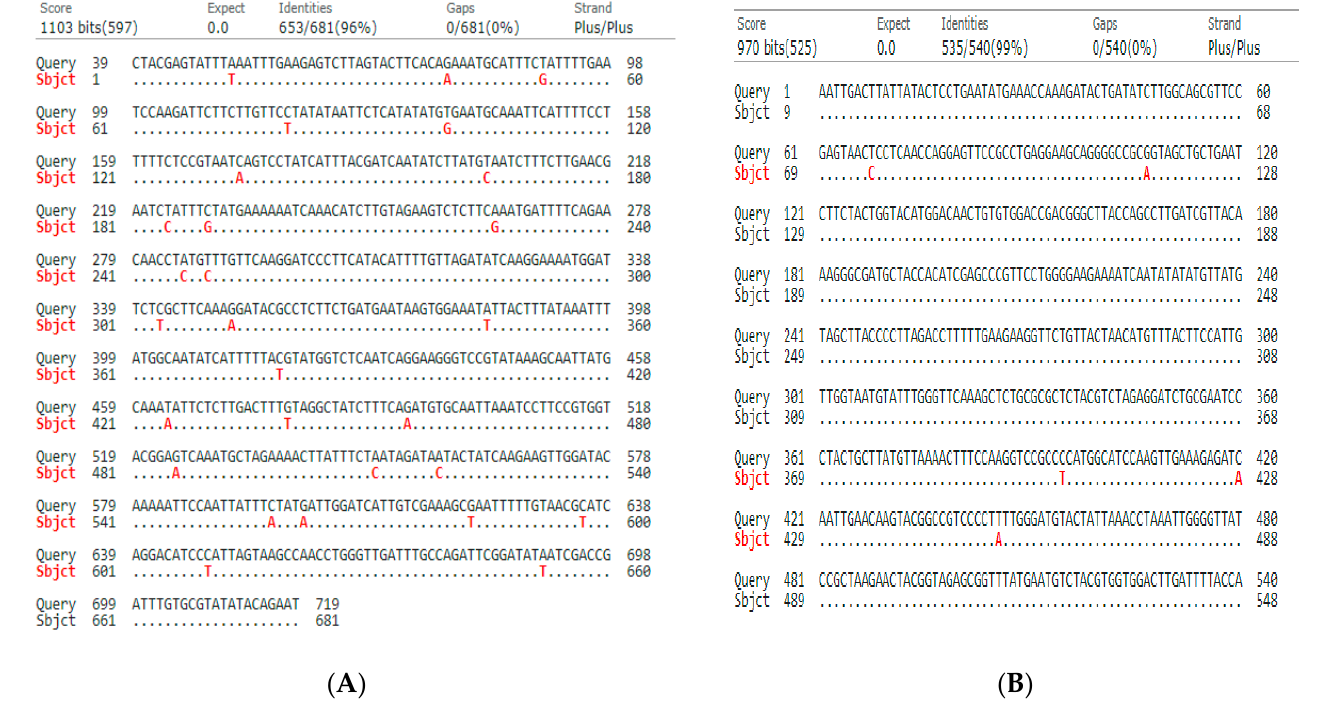
Figure 1. Pairwise alignment of Daphne mucronata and Thymelaea hirsuta using dots method (BLAST): ( A ) matK of Daphne mucronata (Query) and Thymelaea hirsuta (subject); ( B ) rbcL of Daphne mucronata (Query) and Thymelaea hirsuta (subject).